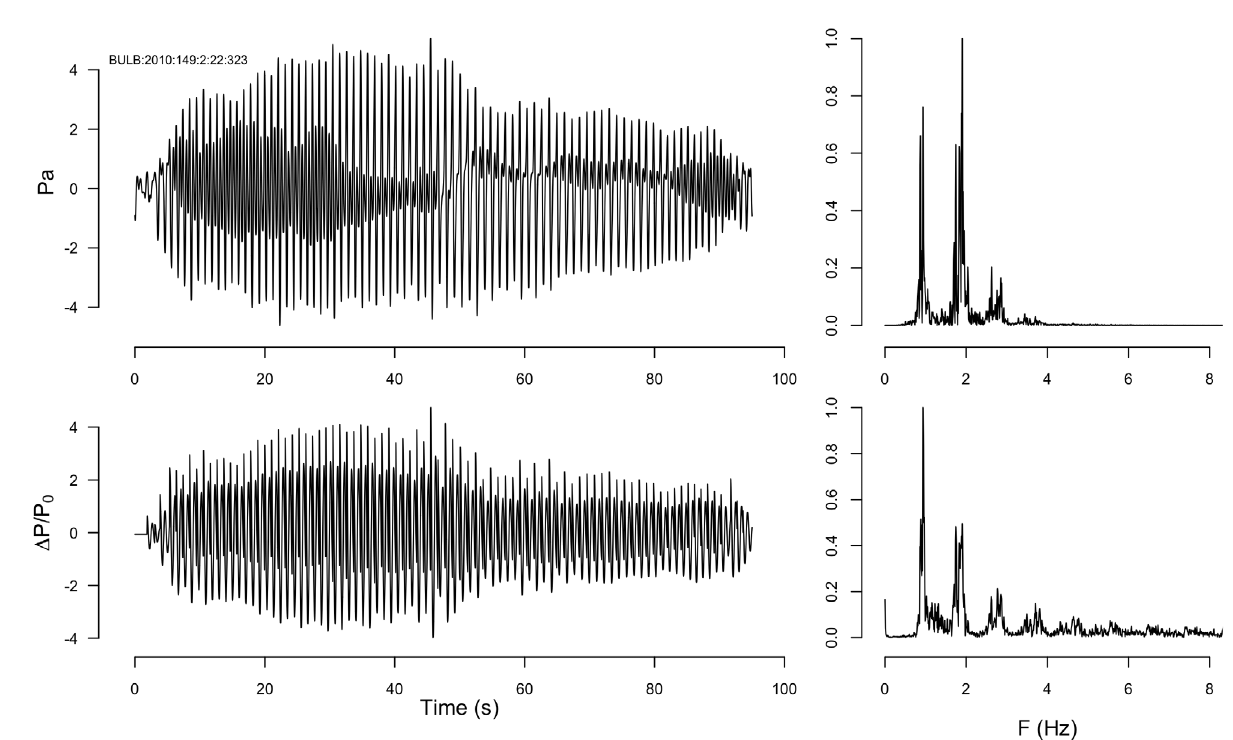
Figure 6: Recorded Tungurahua chugging sequence (top) with modeled waveform output from the oscillating gas pocket model (bottom) [Girona et al. 2019]. Results for other Tungurahua, Karymsky, or Fuego sequences can be provided on request. Normalized amplitude spectra are the same as the Tungurahua results in Figure 5. Data was recorded on May 28,